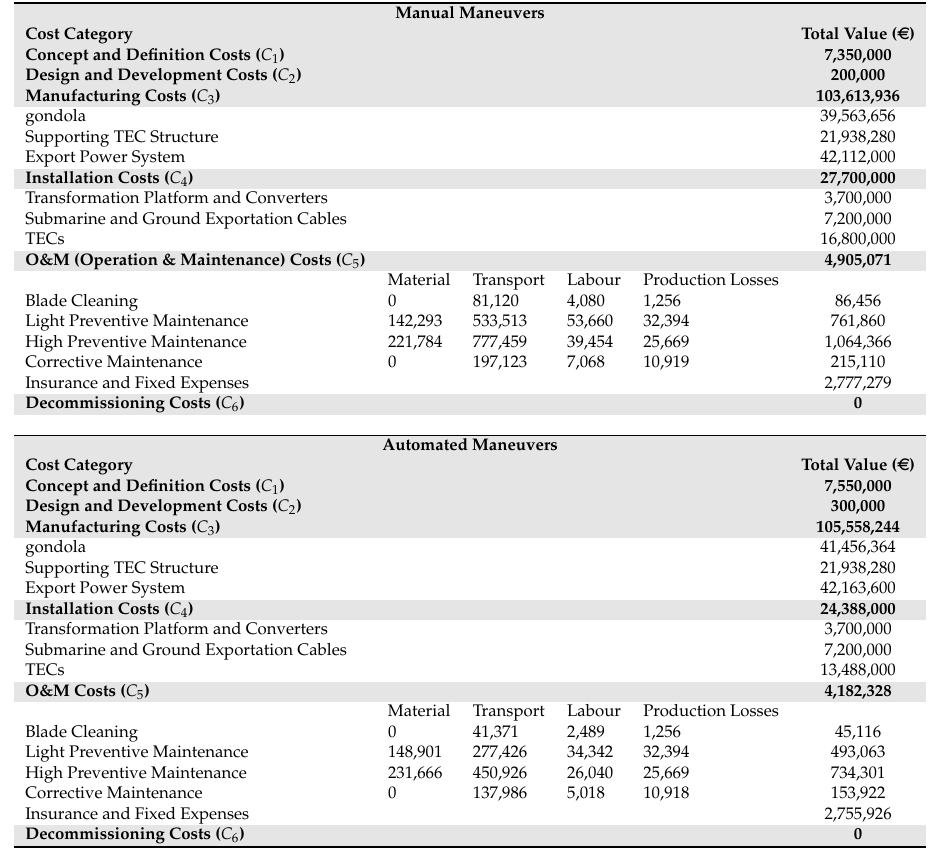
Table 1. Summary of the cost of the TEF (Tidal Energy Farm) composed of TECs in the case of manual and automated maneuvers ( C 1 , C 2 , C 3 and C 4 are applied for the first time of the project while C 5 is applied